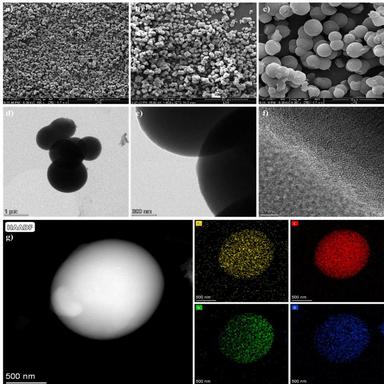
Characterization of Fc-PP-POP. a-c) SEM of Fc-PP-POP at the scale bar of 100, 50 and 10 µm, respectively; d-f) TEM of Fc-PP-POP at the scale bar of 1 µm, 200 nm, 5 nm, respectively; g) The elemental mapping of Fc-PP-POP.